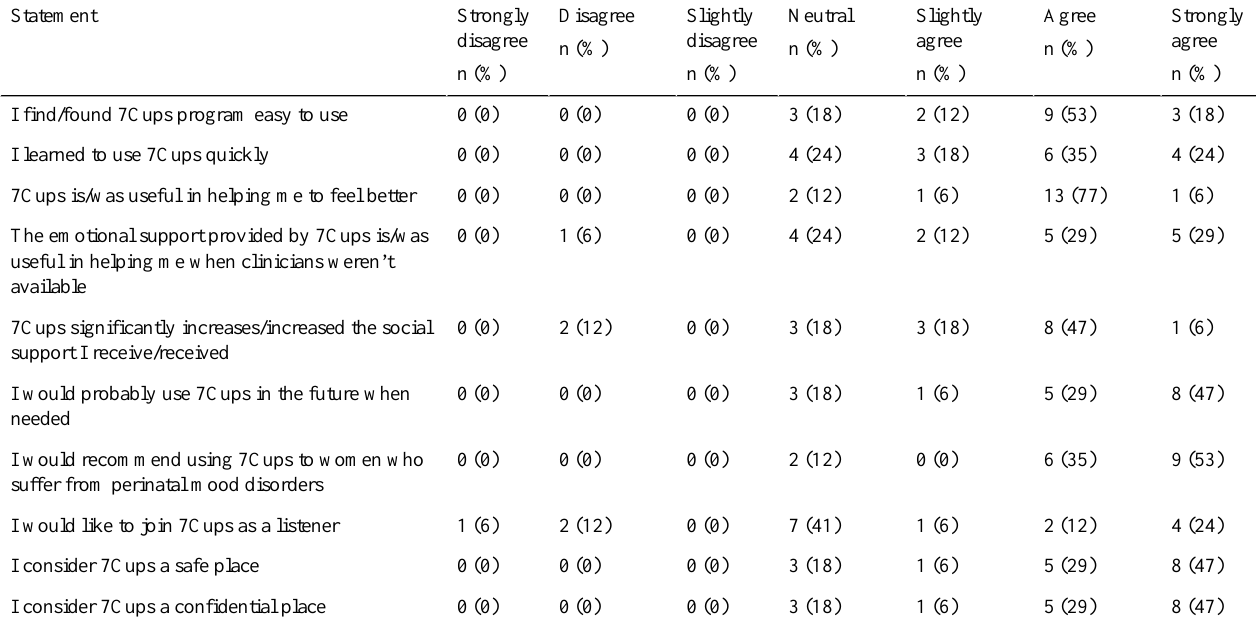
Table 3. Participant responses to usability and acceptability measures (n=17).